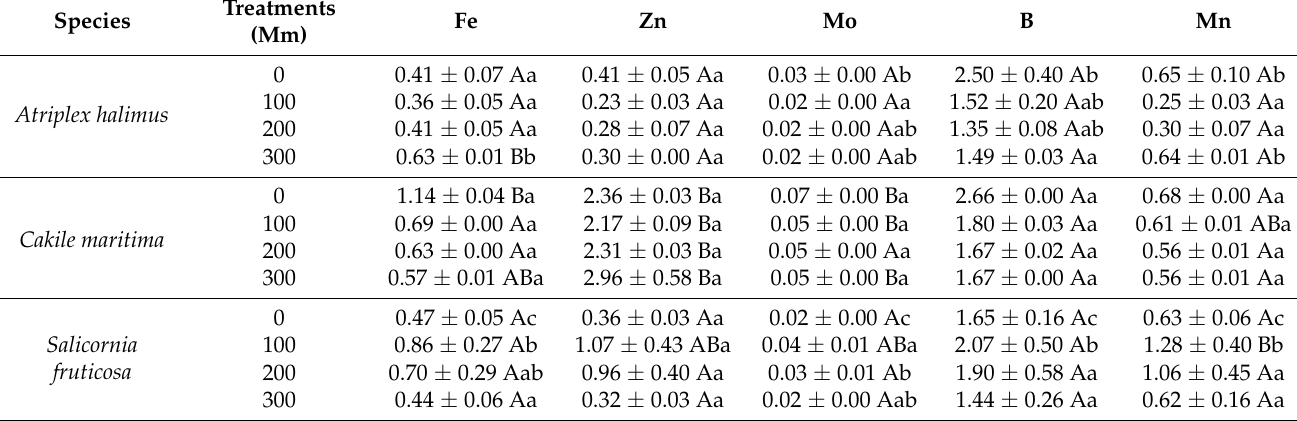
Table 2. Micronutrients content in the leaves and stems of Atriplex halimus , Cakile Maritima , and Salicornia fruticosa grown with different salinity doses (0, 100, 200, and 300 mM NaCl) for two weeks. Cation concentrations are expressed as mg 100 g − 1 DW (mean ± SE, n = 5). Values followed by different letters are significantly different at p < 0.05; upper-case letters indicate the differences among the salinity treatments for the same species, lower-case letters indicate the differences among the species for the same treatment. The Tukey HSD test was used for the comparison of